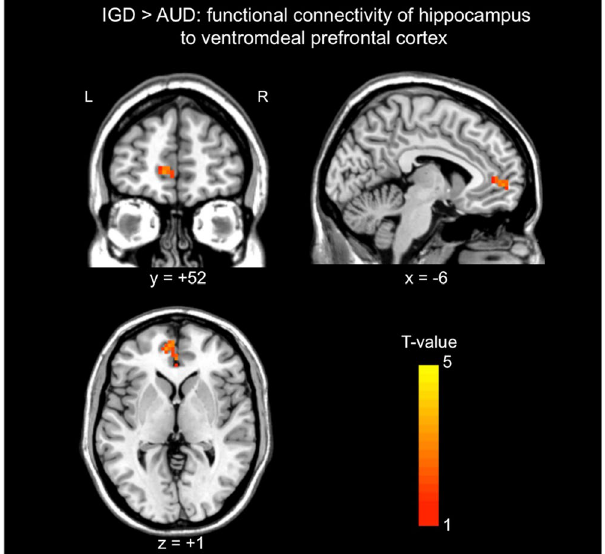
Figure 4. Results of functional connectivity anaysis with a seed region consisting of the hippocampus/ amygdala showing volume differences in individuals with Internet gaming disorder (IGD) compared to those with alcohol use disorder (AUD). The left ventromedial prefrontal cortex showed stronger fuctional connectivity in the individualss with IGD compared to those with AUD. AUD, alcohol use disorder; IGD, Internet gaming